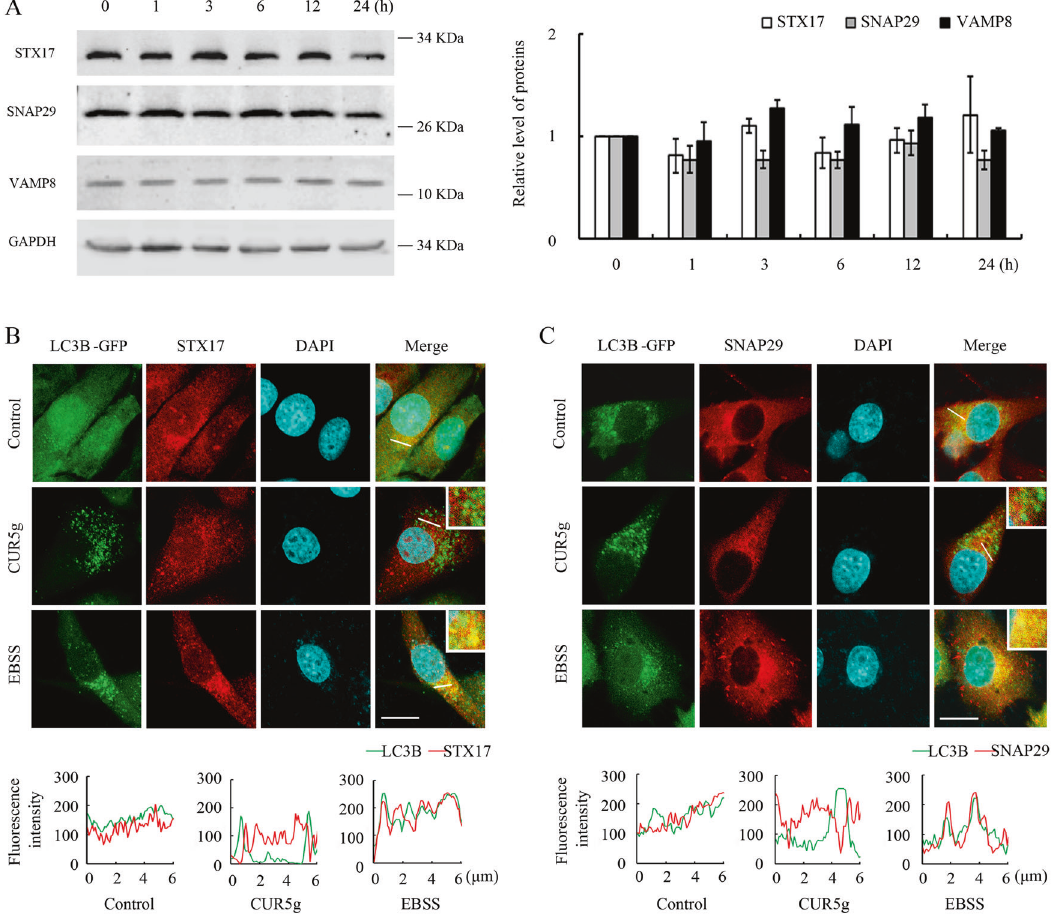
Fig. 4 CUR5g blocks incorporation of STX17 on autophagosomes. A Western blot analysis of STX17, SNAP29, and VAMP8 levels in A549 cells treated with CUR5g (10 μ M) for 0 – 24 h. GAPDH was used as a loading control. B , C Representative fl uorescence images of the colocalization of LC3B (green) and STX17 (red) ( B ) or LC3B (green) and SNAP29 (red) ( C ). Nuclei were stained with DAPI. The line-scanned pro fi les show the distribution of fl uorescence for each channel in the white line in the corresponding confocal images. Scale bar = 10 μ